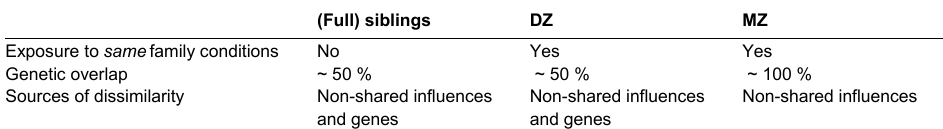
Similarity and dissimilarity of siblings and